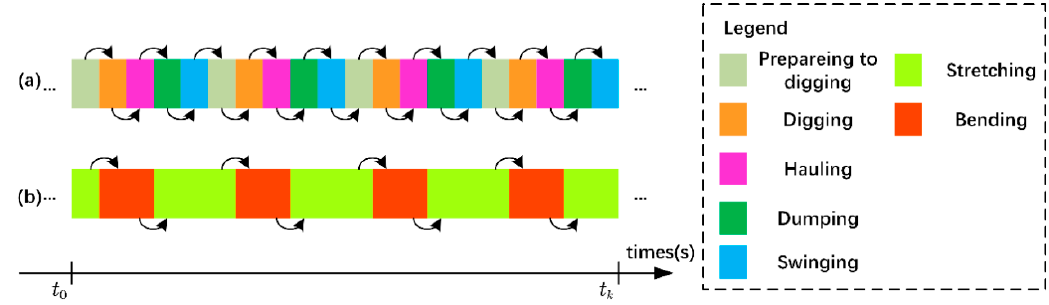
Figure 3. ( a ) Five-atomic-action sequential pattern and ( b ) stretching-bending sequential pattern (SBSP) in video sequence.